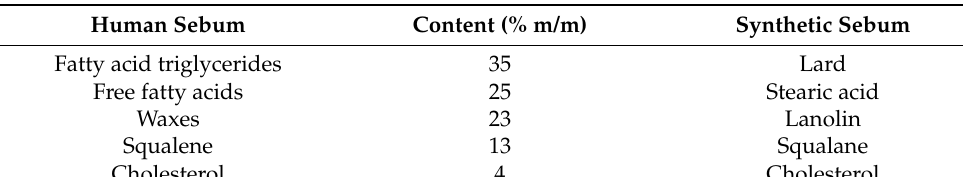
Table 1. Composition of real and synthetic sebum.